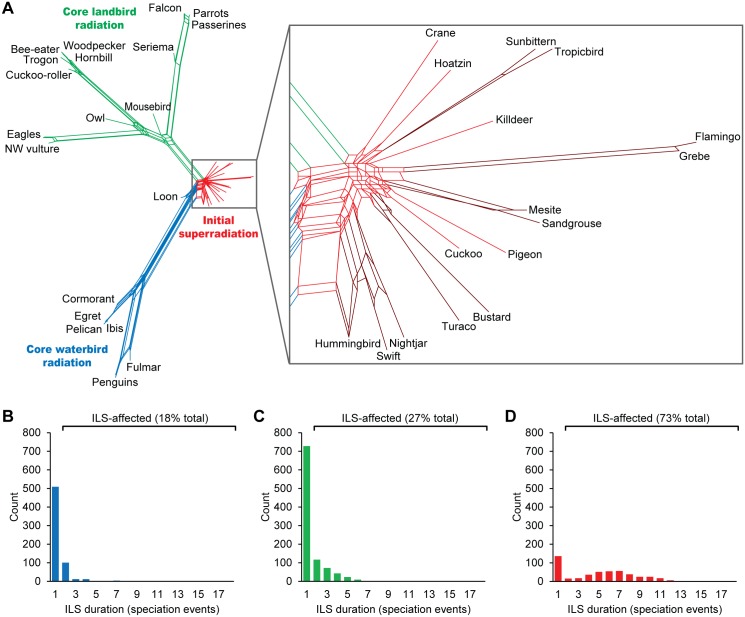
Phylogenetic network of rare genomic changes reveals three adaptive radiations of Neoaves with varying complexity of genealogical incongruences.(A) Neighbor-net [31] analysis of 2,118 RE presence/absence patterns suggests that Neoaves diversification may be more accurately visualized as a largely bifurcating tree with highly reticulate structures at the base of the core landbird radiation and across most of the initial super-radiation. Within the latter, red-brown reticulations highlight bifurcate relationships (cf. Fig 1A and 1B) with limited conflict if stretched boxes are longer than they are wide. In contrast, the core waterbird radiation exhibits limited conflict and appears fully bifurcating (cf. Fig 1A and 1B). (B–D) Distribution of frequencies of RE markers without and with ILS (i.e., persistence across ≥two speciation events) for each of the three adaptive radiations (S3 Table). (B) Core waterbird radiation with 18% total ILS, mostly across two speciation events. (C) Core landbird radiation with 27% total ILS, most of which led to weak or moderate conflict via ILS across two to three speciation events. (D) The initial super-radiation exhibits 73% total ILS, almost exclusively with strong discordances caused by persistence of ILS across five or more speciation events.